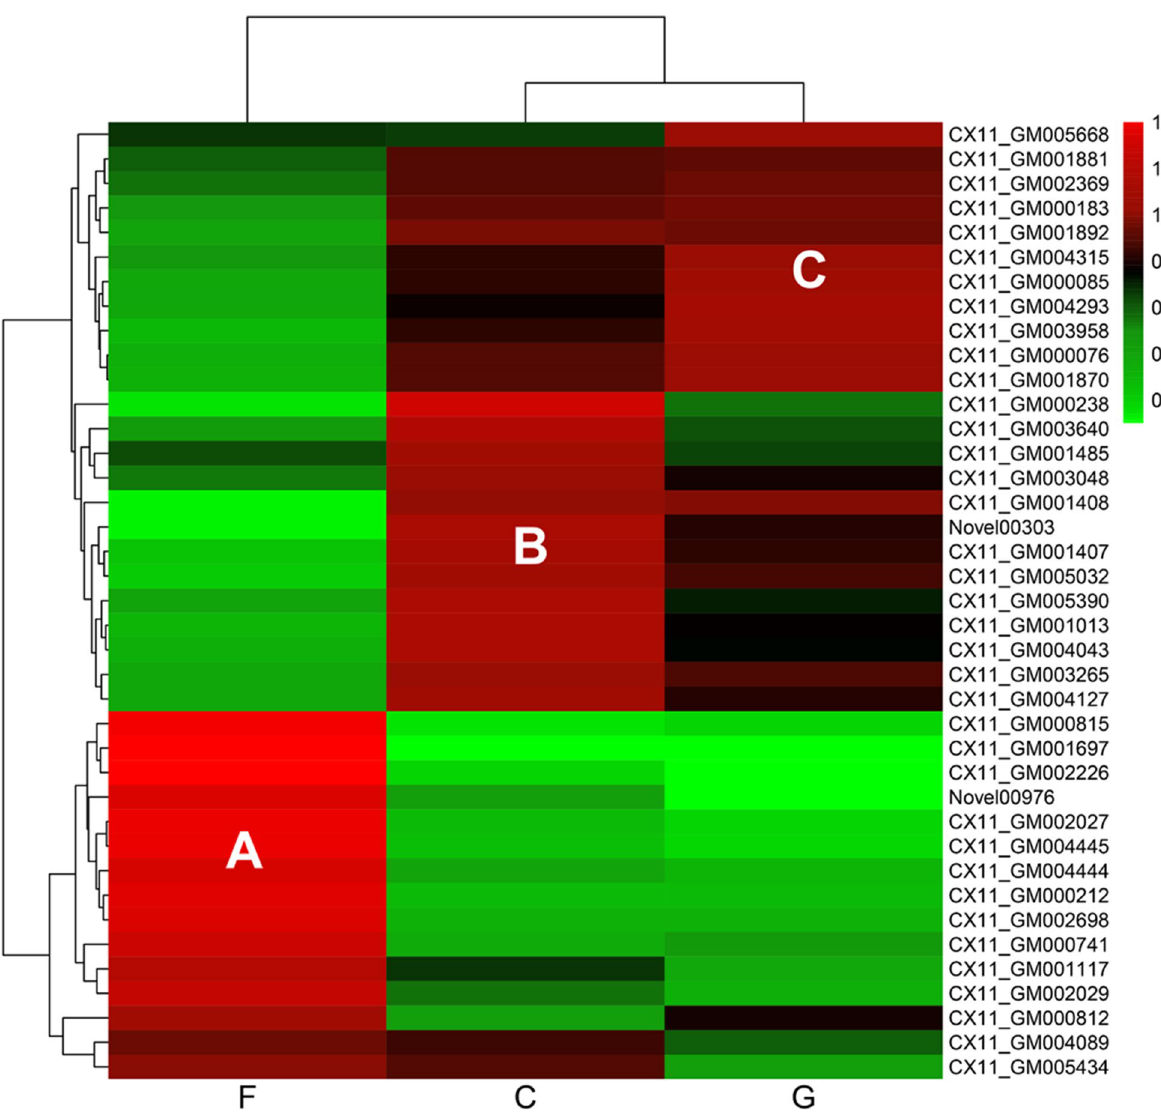
Fig. 4 Heat map of clustering of differentially expressed gliding function-related genes. (F/C/G: fermentation supernatant using filter paper, cellobiose and glucose as the sole carbon source,